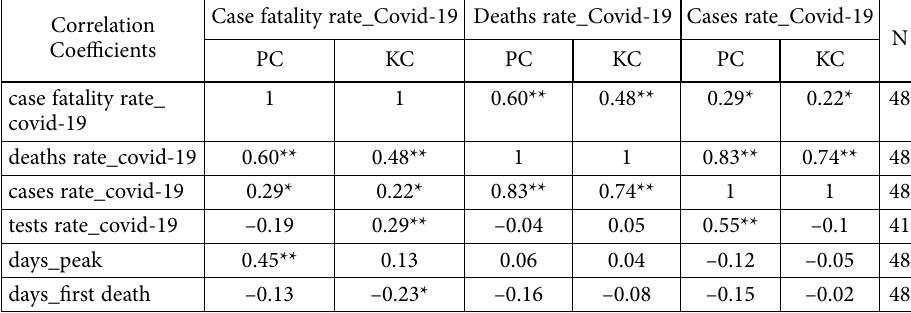
Table 4. Correlation analysis between Covid-19 indicators (source: authors’ computation using IBM SPSS Statistics 21) Correlation